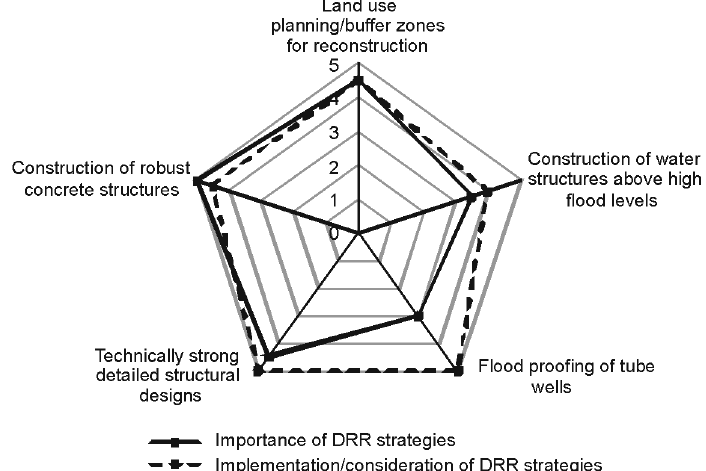
Fig. 1. Comparison of importance of physical/technical strategies and their level of implementation/consideration